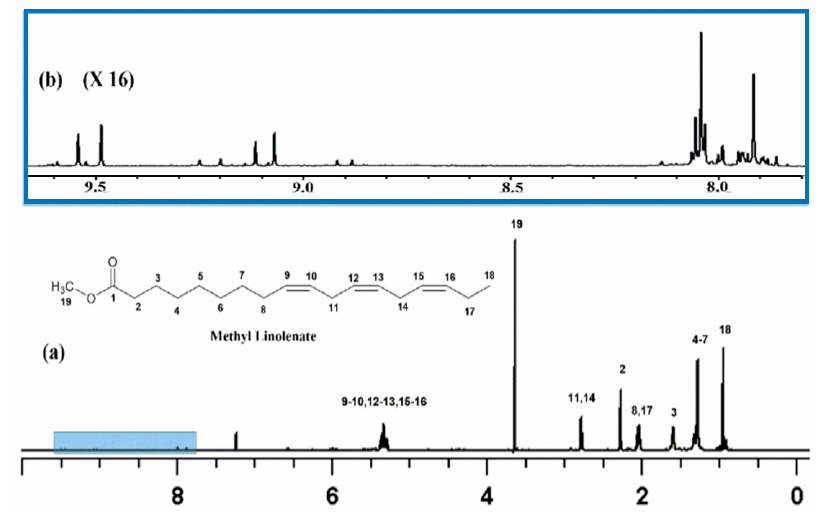
Figure 1. ( a ) 800 MHz 1 H-NMR spectrum of 20 mg methyl linolenate in CDCl 3 subjected to heating at 40 °C for 48 h, number of scans = 64, acquisition time = 1.02 s, experimental time = 6.5 min, relaxation delay = 5 s, T = 298 K; ( b ) selected region of the C–O–O–H resonances of its primary oxidation products.